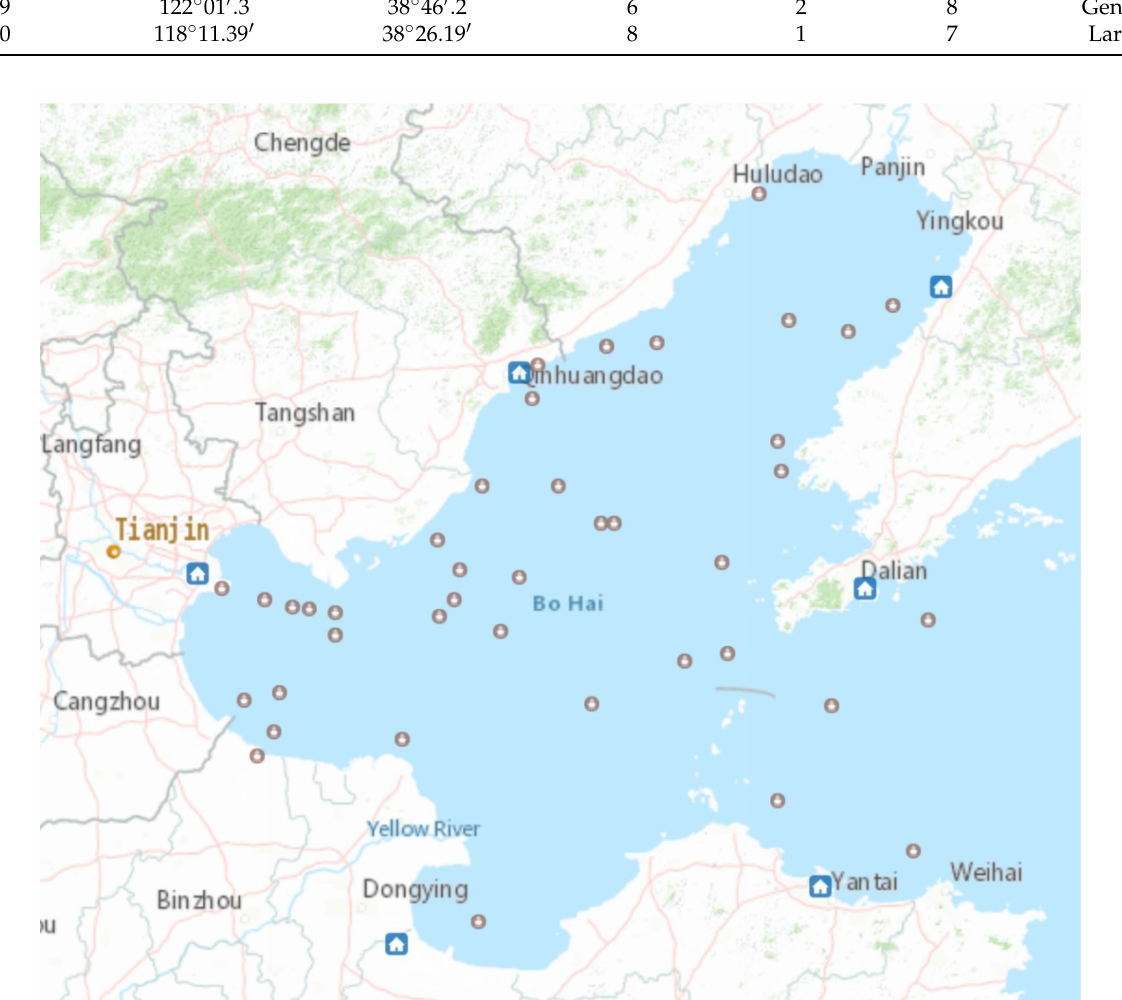
Figure 4. Distribution map of candidate emergency materials reserves and potential accident